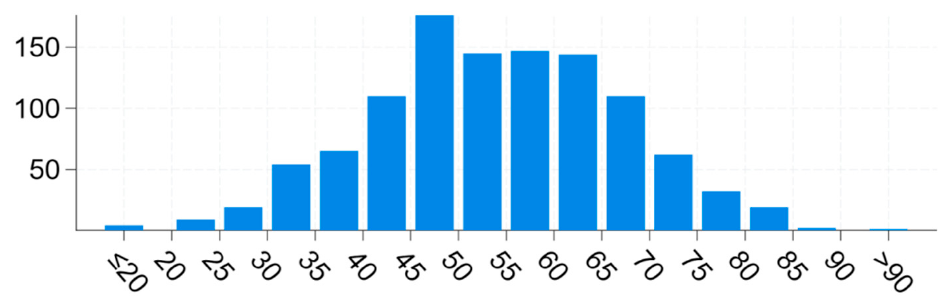
Figure 2. Patients’ distribution by